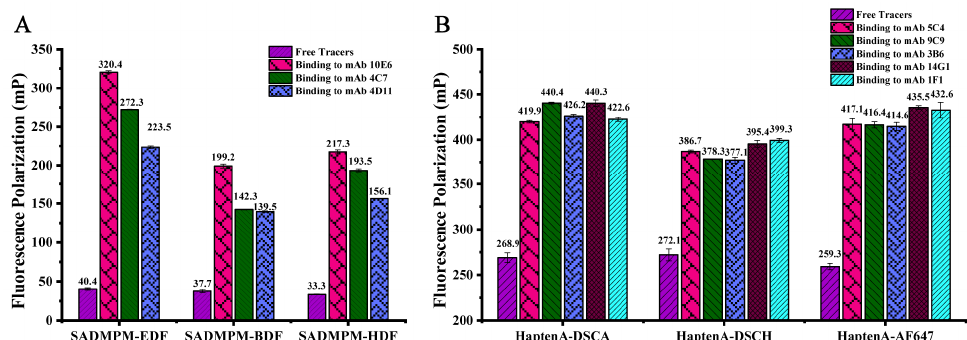
Figure 2. The tracers are characterized by the antibody binding assay. ( A ) The tracers of SAs had binding with 100-fold diluted mAbs of 10E6, 4C7, and 4D11 ( n = 3). ( B ) The tracers of ASGs had binding with 100-fold diluted mAbs of 5C4, 9C9, 3B6, 14G1, and 1F1 ( n = 3).